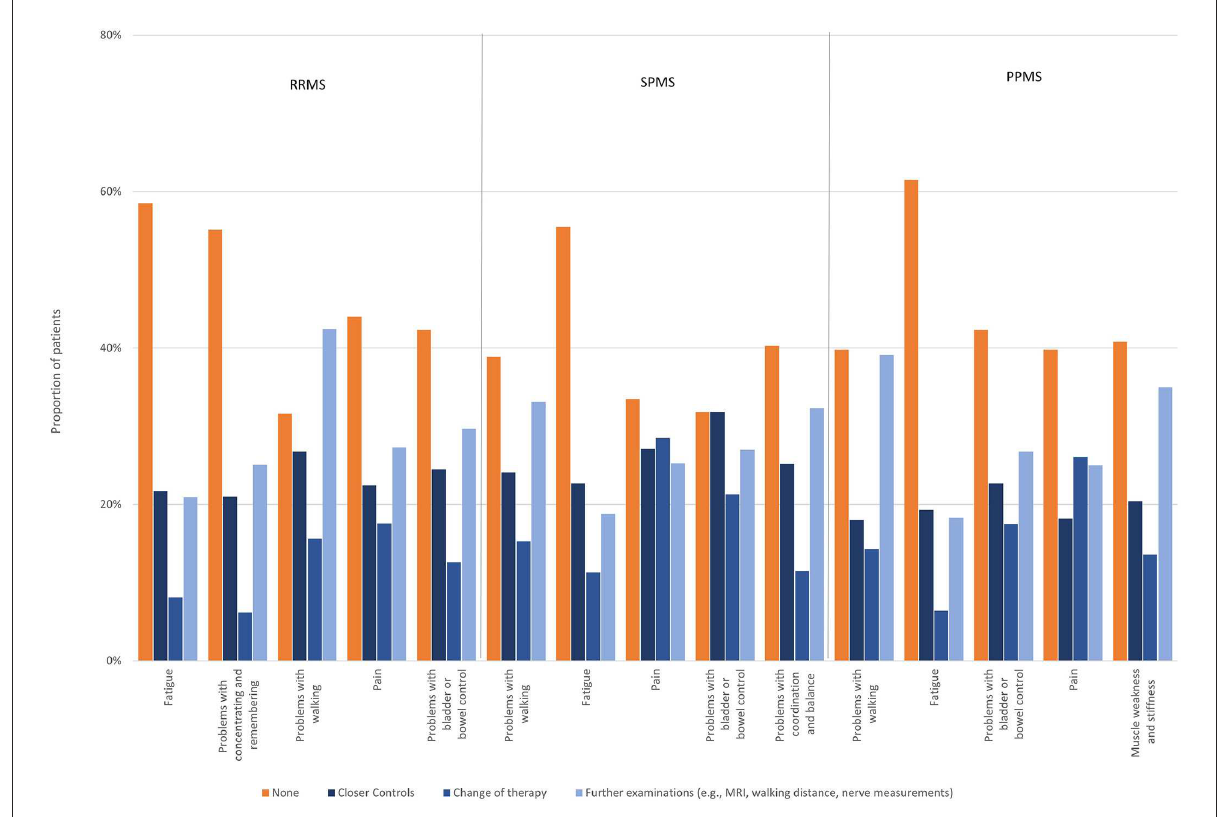
FIGURE6 Actions taken regarding most disabling symptoms worsened in the last 12 months independent of relapses by